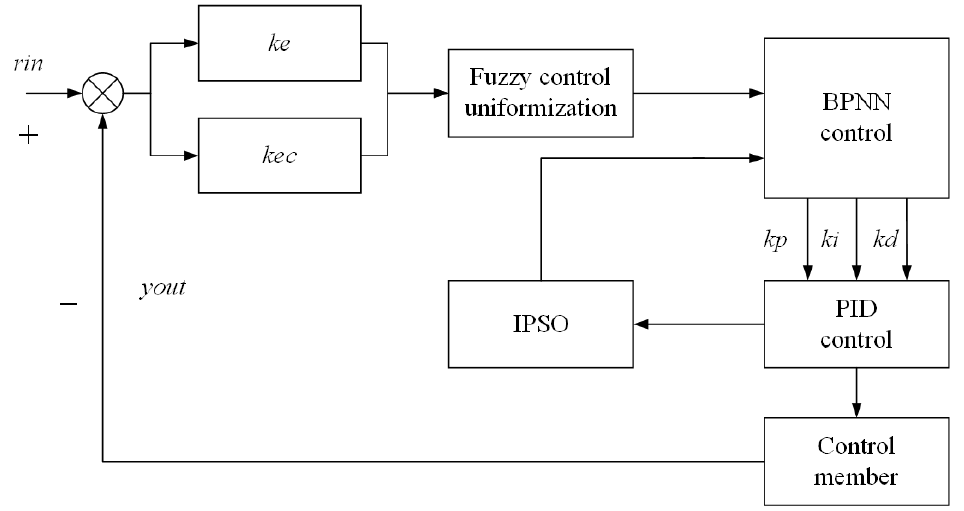
Figure 10. IPSO-Fuzzy-BPNN-PID system schematic diagram.